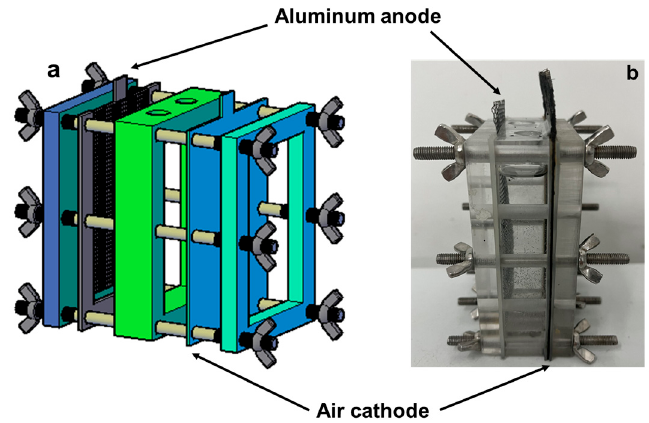
Figure 1. Schematic diagram ( a ) and photo ( b ) of the aluminum–air fuel cell for